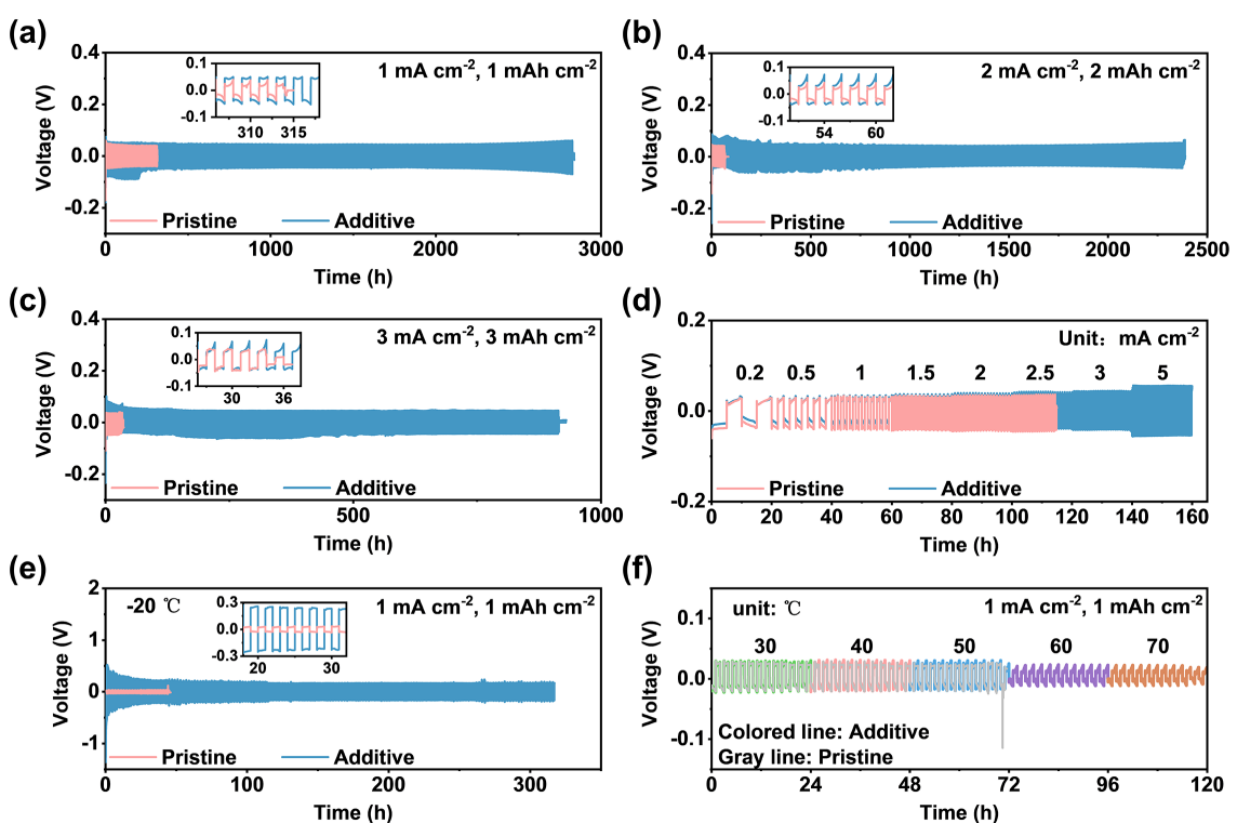
Figure 3. Electrochemical characteristics of Zn|Zn cells. ( a – d ) Zn|Zn symmetric cells with pristine electrolyte and additive-containing electrolyte at 1 mA cm − 2 , 2 mA cm − 2 , 3 mA cm − 2 , and varying current densities. ( e , f ) Zn|Zn symmetric cells with pristine electrolyte and additive-containing electrolyte at −20 °C and different temperatures from 30 °C to 70 °C.